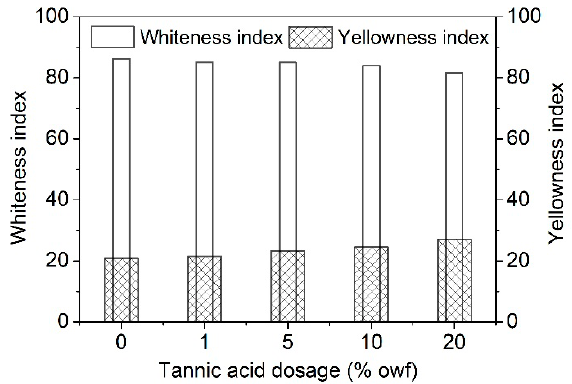
Figure 7. Whiteness and yellowness indexes of the silk fabrics treated with di ff erent concentrations of tannic acid.